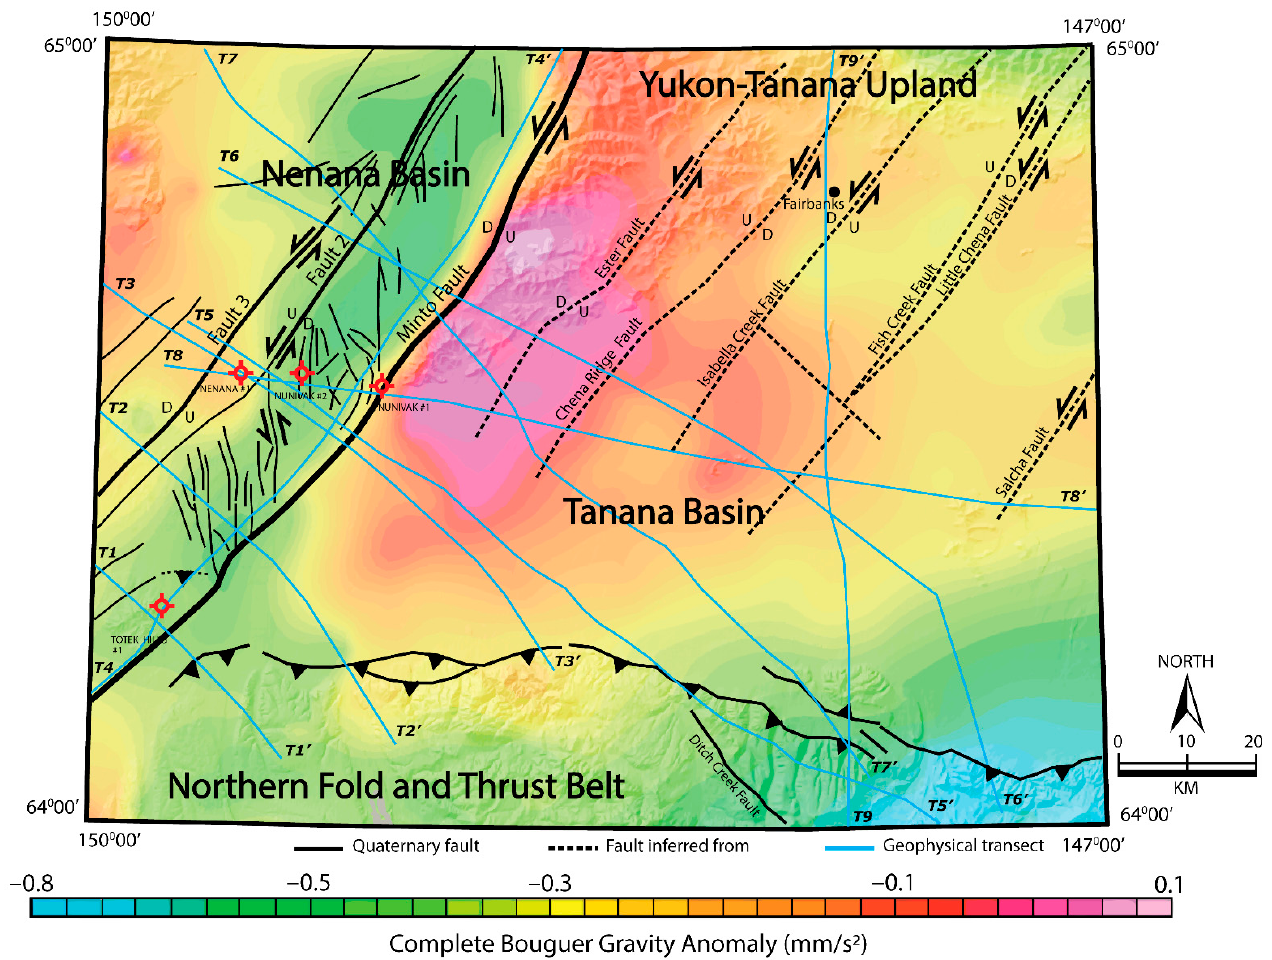
Figure 7. The complete Bouguer gravity anomaly map of the Fairbanks quadrangle, central Alaska. Maps are modified from Meyer [39]. Solid blue lines indicate the geophysical transects presented in our study.